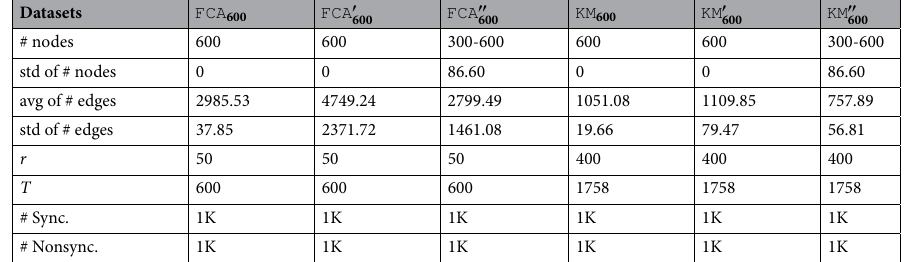
Table 3. Dynamics datasets generated for FCA and Kuramoto on 600 nodes ( FCA 600 , KM 600 , FCA ′ 600 , KM ′ 600 ) and on 300–600 nodes ( FCA ′′ 600 , KM ′′ 600 ). In each dataset, all graphs are connected and non-isomorphic. # Sync. denotes the number of examples in the dataset such that the phase configuration X T at iteration T is concentrated. Here r and T refers to the training and the prediction iterations defined in Table